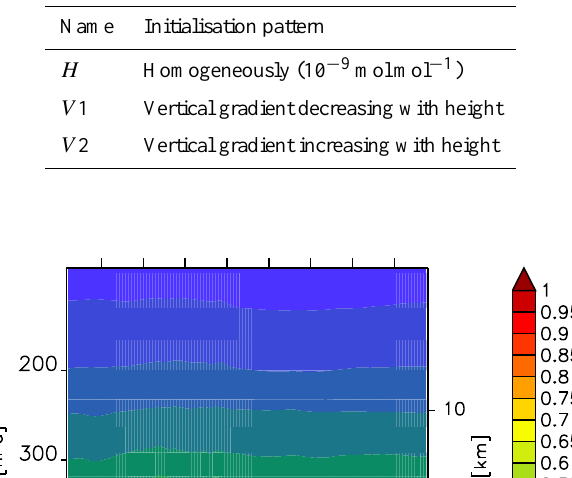
Table 2. Definition of initialisation patterns for passive tracers used in this study.